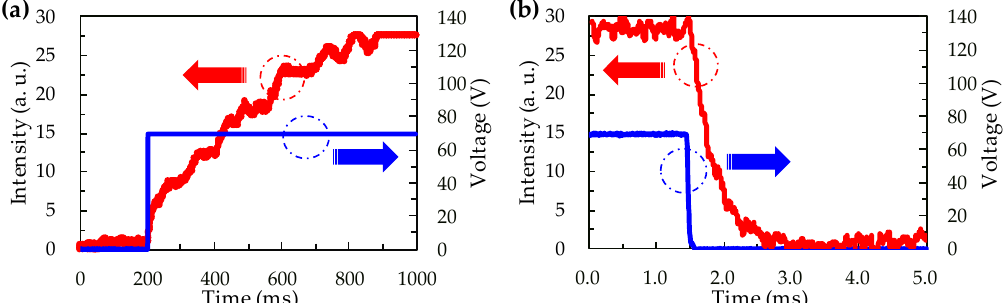
Figure 6. Response time of the BPLC microlens array with the voltage ( a ) switched on to 70 V, and ( b ) switched off from 70 V to 0 V.